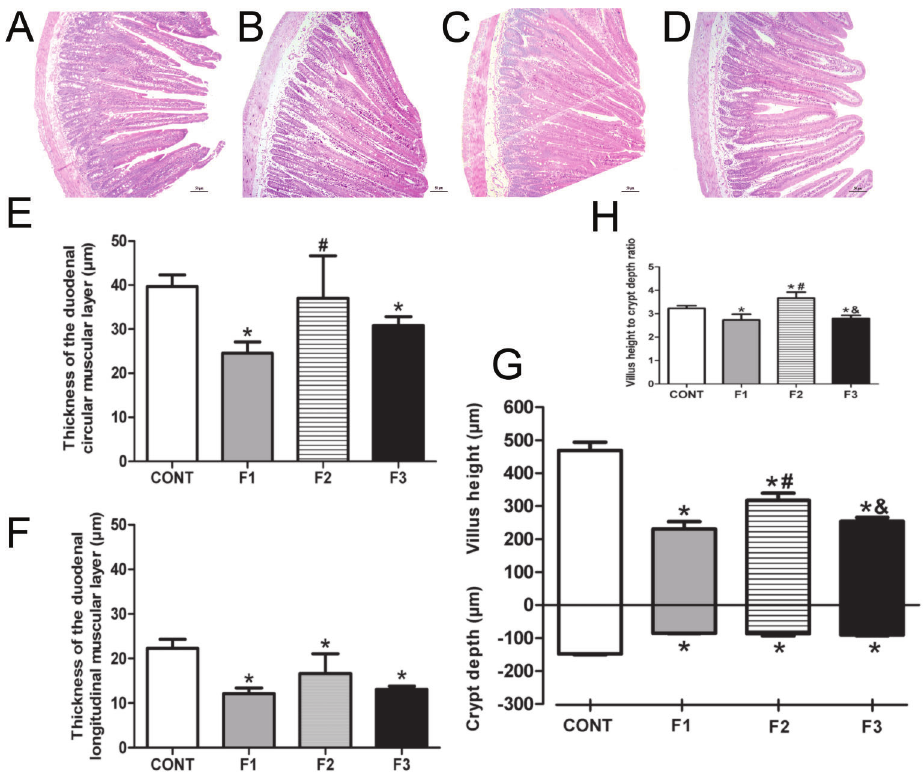
Figure 4. Histological photomicrographs of H&E staining of the duodenum ( A – D ) of Control (CONT), monosodium glutamate (MSG)- induced obese rats (F1), obese offspring (F2), and grand offspring (F3) ( (cid:1) 10 objective, scale bar, 50 m m). Quanti fi cation of the thickness of the duodenal circular muscle layer ( E ) and longitudinal muscle layer ( F ), crypt depth, villus height ( G ), and villus height to crypt depth ratio ( H ). Data are reported as means ± SD (n=14 per group). *P o 0.05 compared with CONT, # P o 0.05 compared with F1, and & P o 0.05 compared with F2 (ANOVA followed by Tukey ’ s post hoc